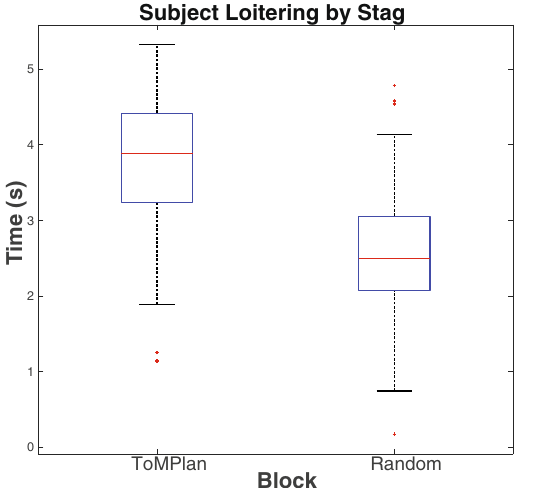
Figure 6. Average time in seconds spent “loitering” next to a stag during a block. Loitering was significantly less for the Random condition (p < 0.001). The x-axis is blocks by agent type, while the y-axis is time in seconds.